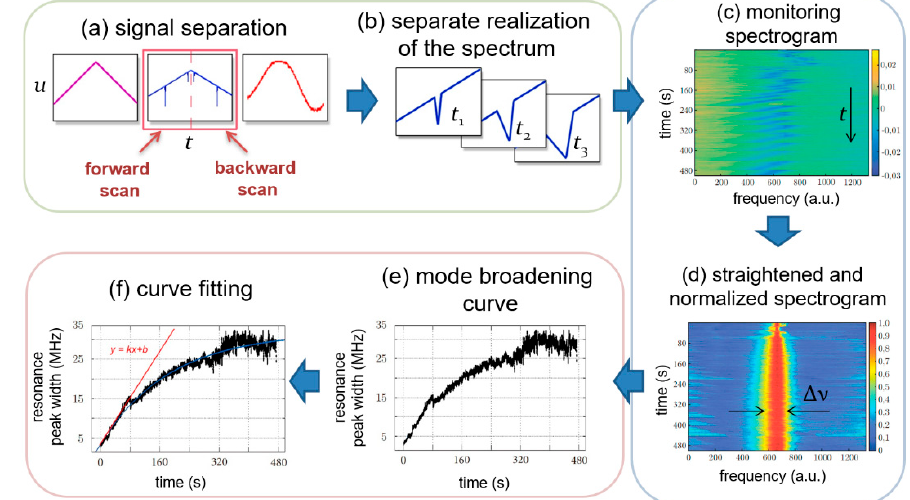
Figure 4. Measuring signal processing algorithm: ( a ) Signals from the laser control unit (violet), microcavity (blue) and reference interferometer (red); ( b ) Separation of the signals containing resonant peaks from the microcavity into individual spectral realizations in time; ( c ) Visualization of a spectrogram of mode monitoring; ( d ) Normalization of the spectrogram and compensation of the resonant frequency shift; ( e ) Selecting a resonant peak and plotting its width at half maximum at each moment in time; ( f ) Approximation of the mode broadening curve and finding the slope of its initial section.